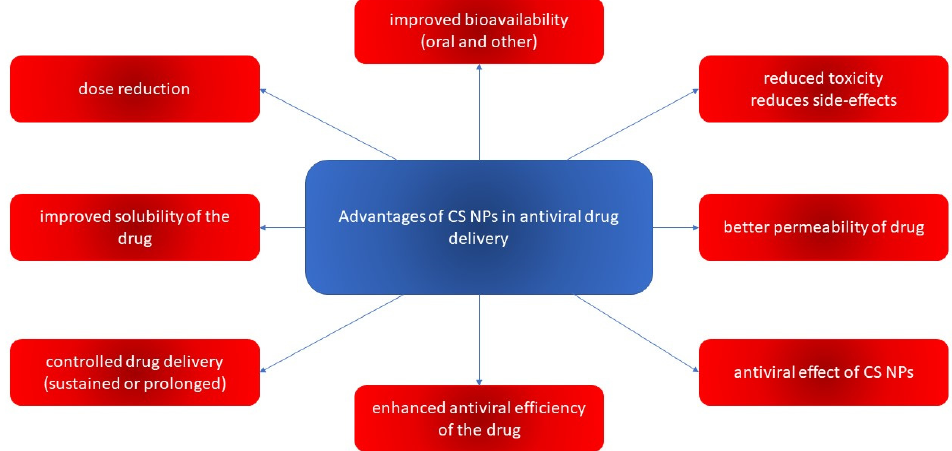
Figure 13. Main advantages of CS NPs in antiviral drug delivery systems.